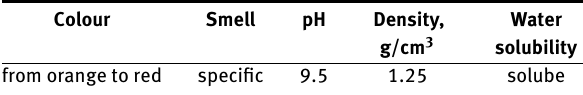
Water g/cm 3 solubility